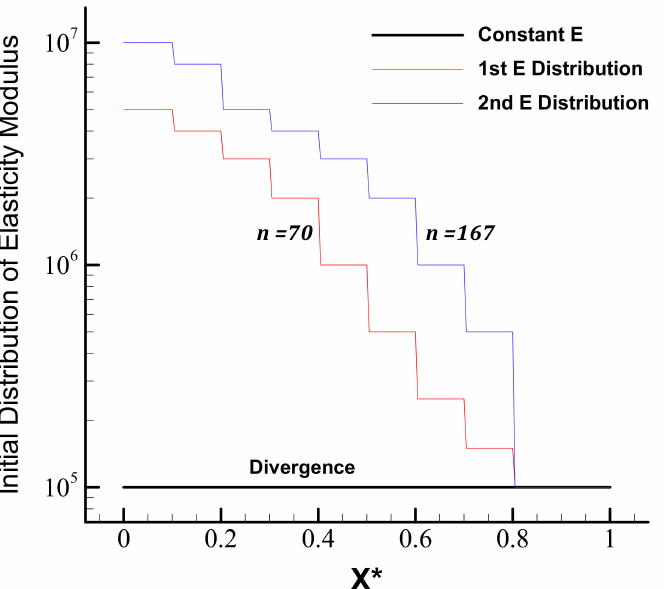
Figure 15. Three different initial distributions of elastic modulus along the blade suction side (versus non-dimensionalized X*—coordinate) in the initial and second design cases by UESA with spine constraint and fixed stagger